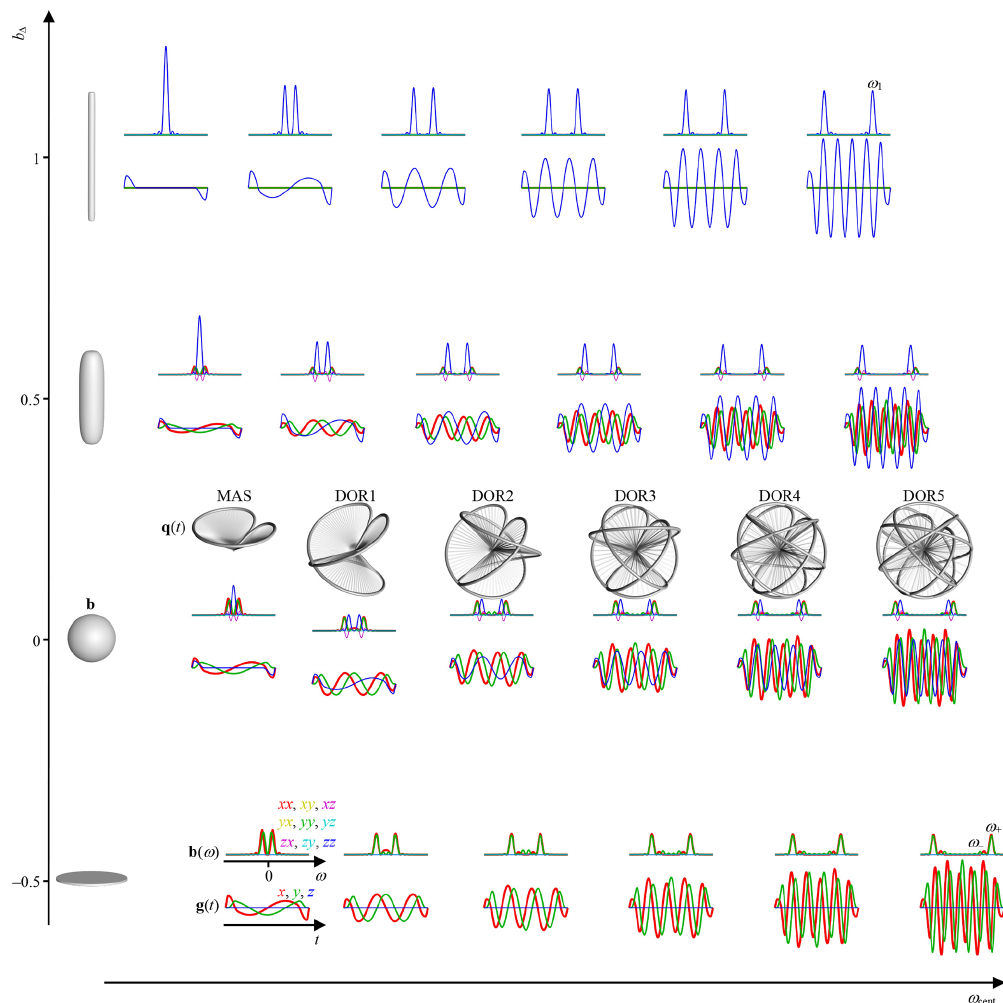
Figure 3. Gradient waveforms g ( t ) for comprehensive exploration of the 2D space of centroid frequency ω cent and anisotropy b (cid:49) of the tensor-valued encoding spectrum b ( ω ). Magic-angle spinning (MAS) and double rotation (DOR n ) with variable frequency ratio n give q - vector trajectories q ( t ) shown as 3D plots for the b (cid:49) = 0 cases. The waveforms are generated according to the scheme in Fig. 2 using ε up = 0 . 03 τ , ε down = 0 . 12 τ , (cid:49)ψ 2 = 360 ◦ , b η = 0, and identical b values for a 2D array of n = 0, 1, ..., 5 and b (cid:49) = − 0 . 5, 0, 0.5, and 1 with the angles ζ 1 = 0 ◦ and ζ 2 = 54 . 7 ◦ for n = 0 and ζ 1 = 90 ◦ and ζ 2 = − 54 . 7 ◦ for n> 0. Superquadric tensor glyphs (Kindlmann, 2004) along the vertical axis illustrate b for the chosen values of b (cid:49) . The main maxima in b ( ω ) are located at the frequencies ω 1 and ω + given in Eq. (57). Values of ω cent and b (cid:49) , including non-idealities originating from the finite durations of the dephasing and rephasing lobes of g 1D ( t ), are obtained via Eqs. (32) and (34), respectively, using numerically evaluated b ( ω ) according to Eqs. (4), (18), and